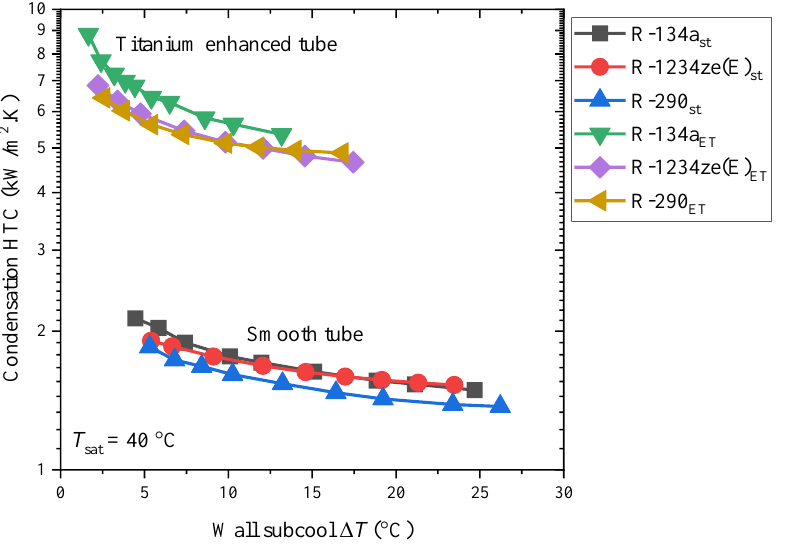
Figure 6. Condensation heat transfer performance of R-134a, R-1234ze(E), and R-290 on smooth tube and titanium-enhanced tube Ji et al. [13].